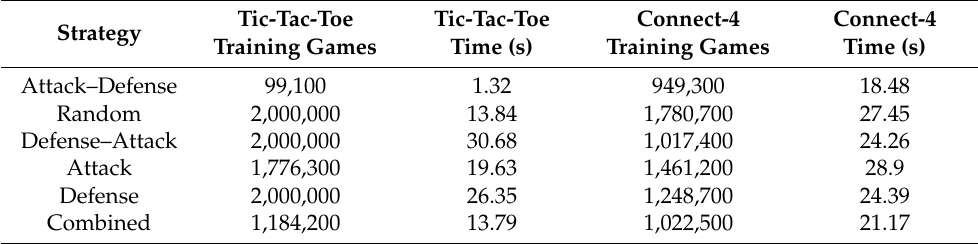
Table 1. Quantitative results in the training phase for the different strategies (average measures).